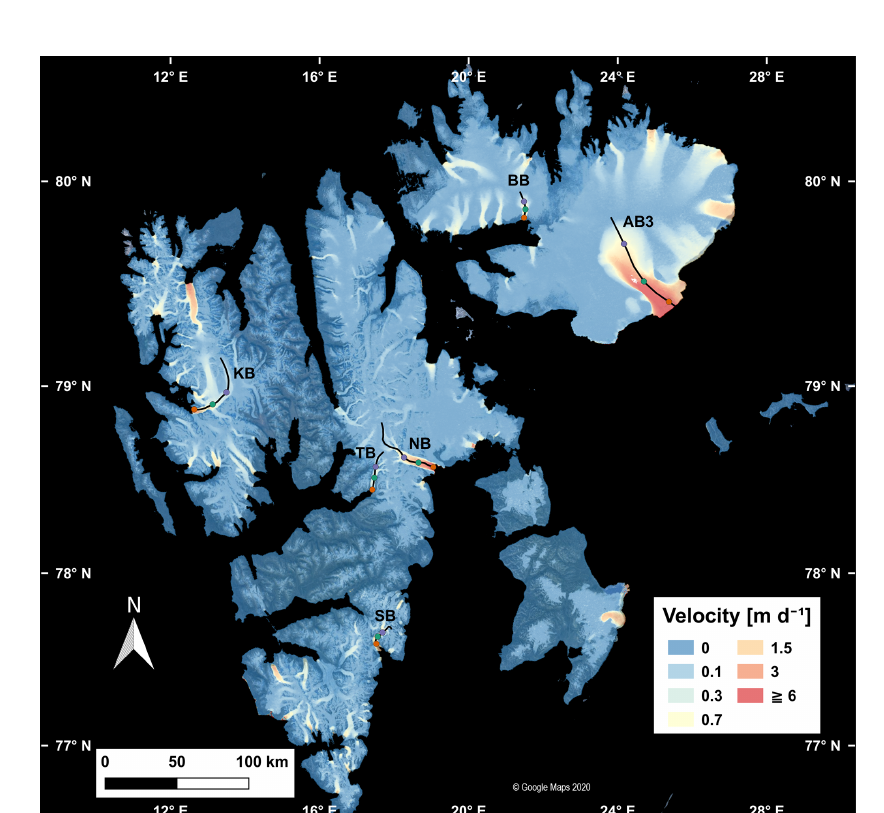
Figure 5. Overview map of Svalbard showing the locations of velocity extraction points on a Sentinel-1 velocity mosaic from 2019. Surface velocities were extracted for six glaciers: Austfonna Basin 3 (AB3), Bodleybreen (BB), Kronebreen (KB), Negribreen (NB), Tunabreen (TB) and Strongbreen (SB). The color coding of the extraction points, distributed along the glacier’s centerlines, is the same as for the corresponding velocity time series in Fig. 6. The color coding indicates the position of the corresponding measuring point on the glacier: purple = upstream; green = mid-glacier; orange = front. Background: © Google Maps 2020, overlain by an OpenStreetMap-based ocean polygon data set in black (https://osmdata.openstreetmap.de/data/water-polygons.html, last access: 28 January 2020, © OpenStreetMap contributors 2019. Distributed under the Open Data Commons Open Database License (ODbL)